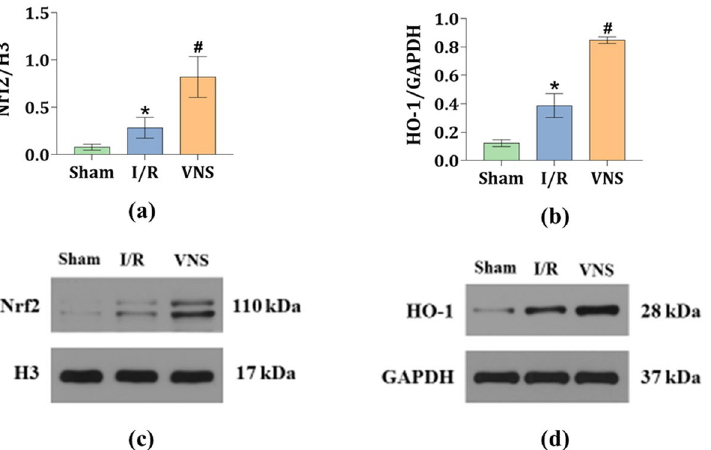
Figure 7. VNS activates the Nrf2/HO-1 signaling pathway in the kidneys after hepatic I/R injury. ( c , d ) Representative blots and relative protein levels of ( a ) Nrf2 and ( b ) HO-1 in kidney tissues from the three groups are shown. *p < 0.05 vs. the Sham group; # p < 0.05 vs. the I/R group. Nrf2 nuclear factor erythroid 2-related